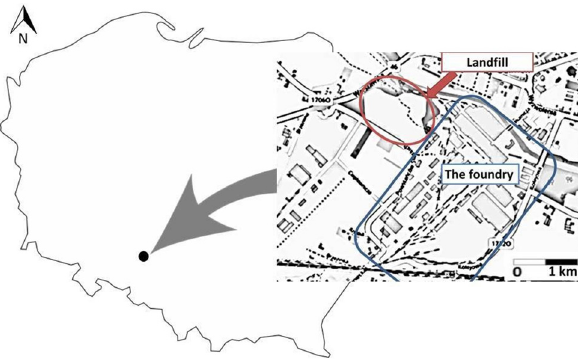
Figure 1: Location of the foundry and land fi ll ( Ozimek, Poland ) . Source: www.google.pl/maps